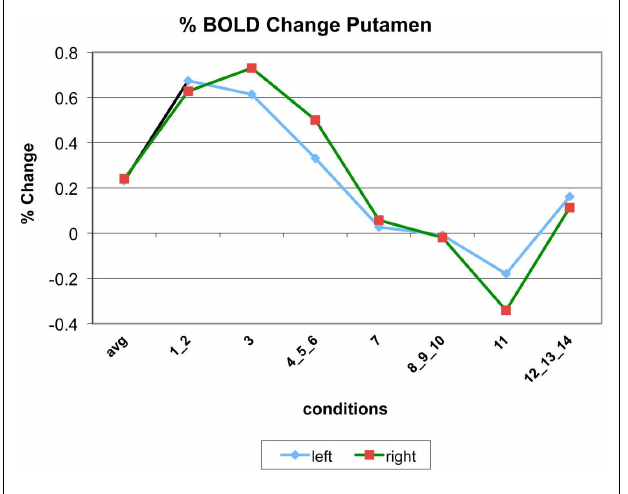
FIGUREA3 |Time series of percentage BOLD change for G(15,3).